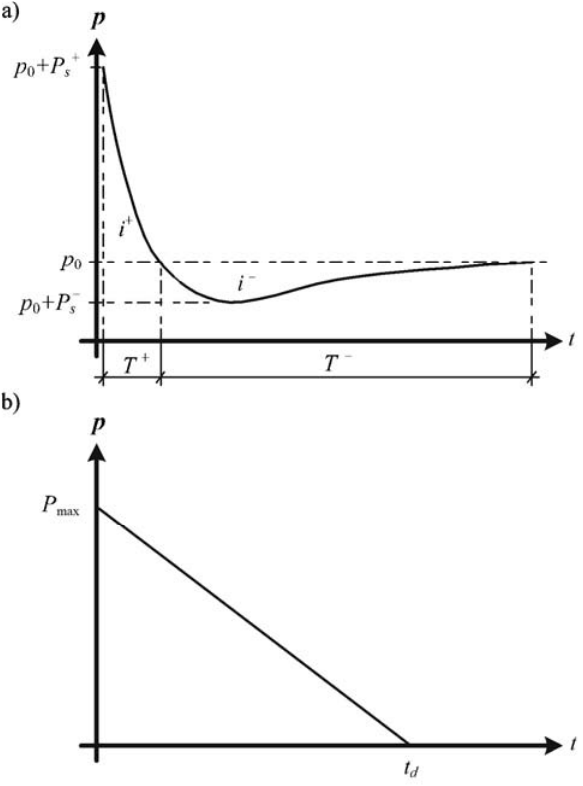
Fig. 2. Pressure time history from a blast: a) exponential form, b) triangular form